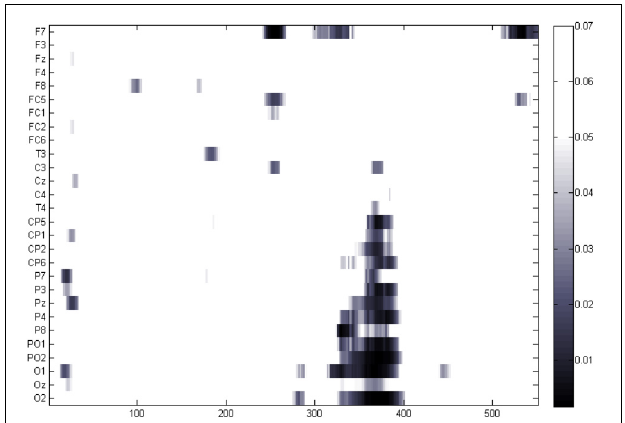
FIGURE 3 | P -values resulting from the paired t -test (FDR corrected) at each sampling point. Colored points correspond to those p -values below